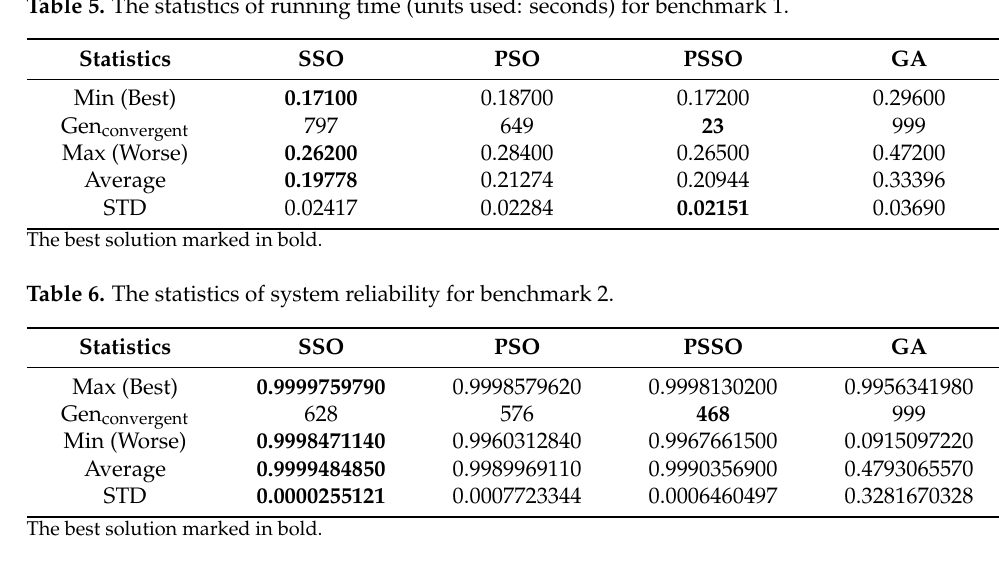
Table 7. The statistics of running time (units used: seconds) for benchmark 2.